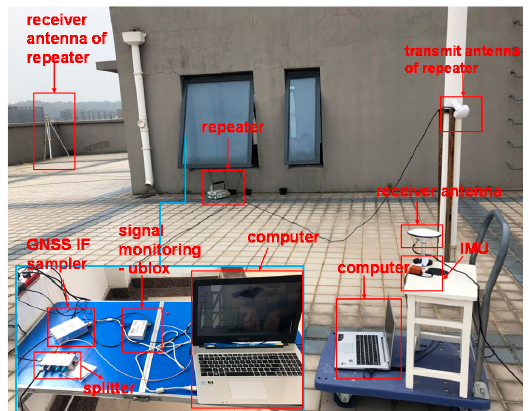
Figure 2. Experimental setup of spoofing attacks on the roof of CEA Building 2.